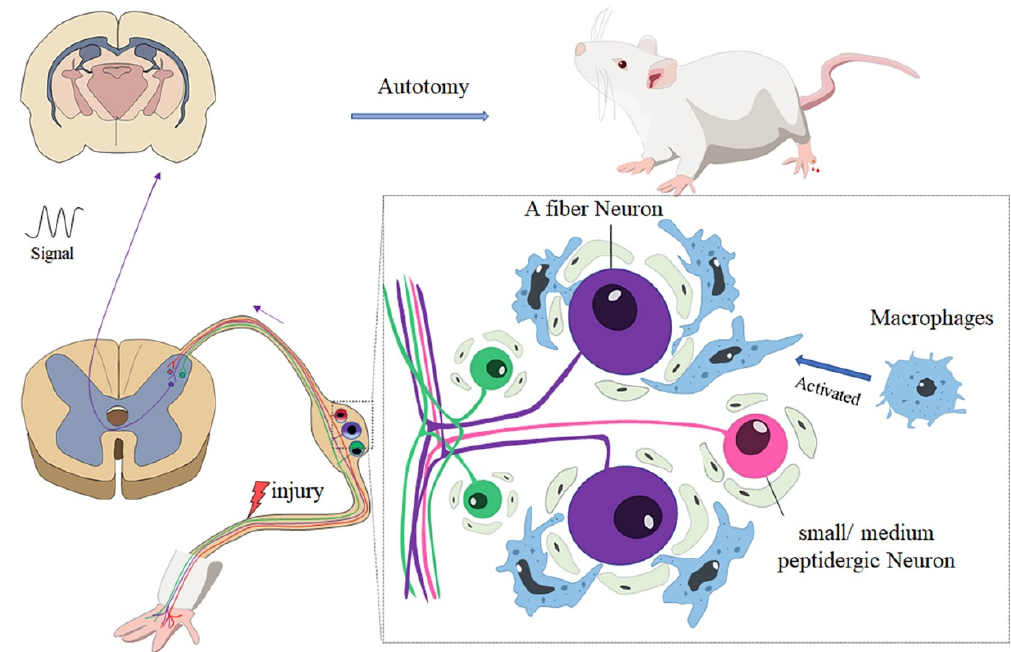
Figure 6. After peripheral nerve injury, macrophages in DRG are activated and distributed around A sensory neurons; the neuro-immunity between macrophages and neurons enhances the generation of abnormal signals and transmits the signal to the brain, which may contribute to autotomy behavior.